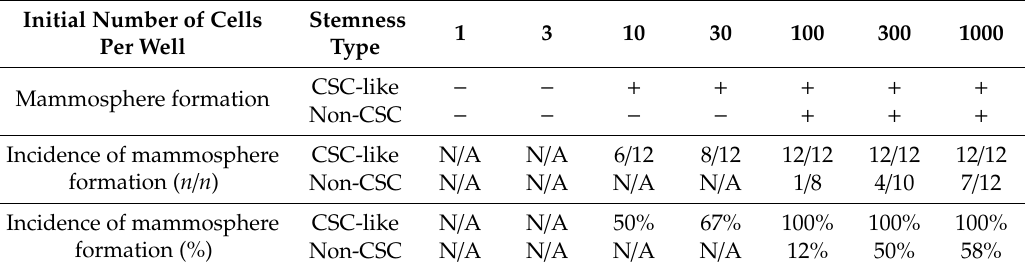
Table 1. Incidence of mammosphere